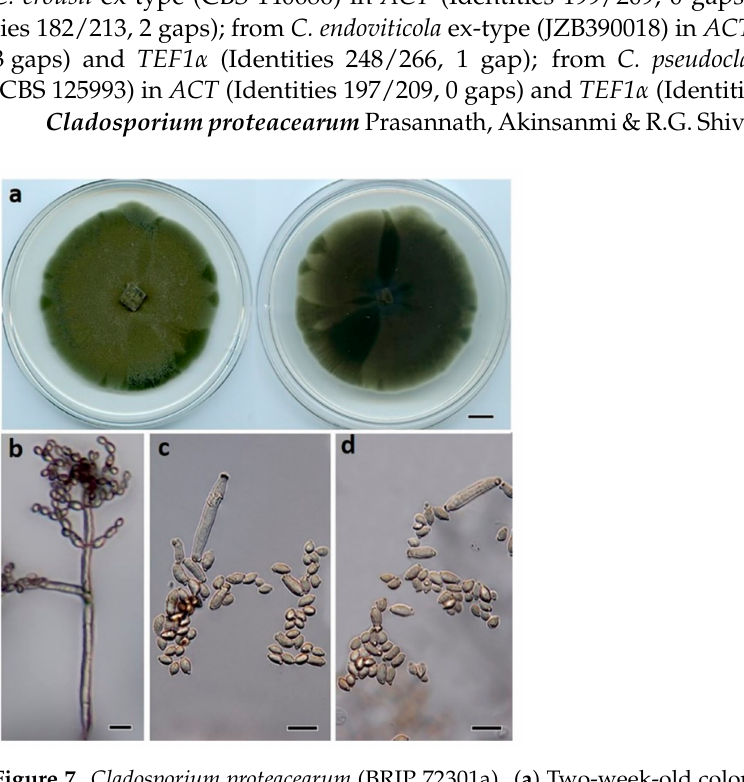
Figure 7. Cladosporium proteacearum (BRIP 72301a). ( a ) Two-week-old colony on PDA (upper sur- face and lower surface), ( b ) conidiophore, ( c ) ramoconidia, and ( d ) terminal conidia. Scale bars: ( a ) = 1 cm; ( b ) = 25 µ m; ( c , d ) = 10 µ m. MycoBank: